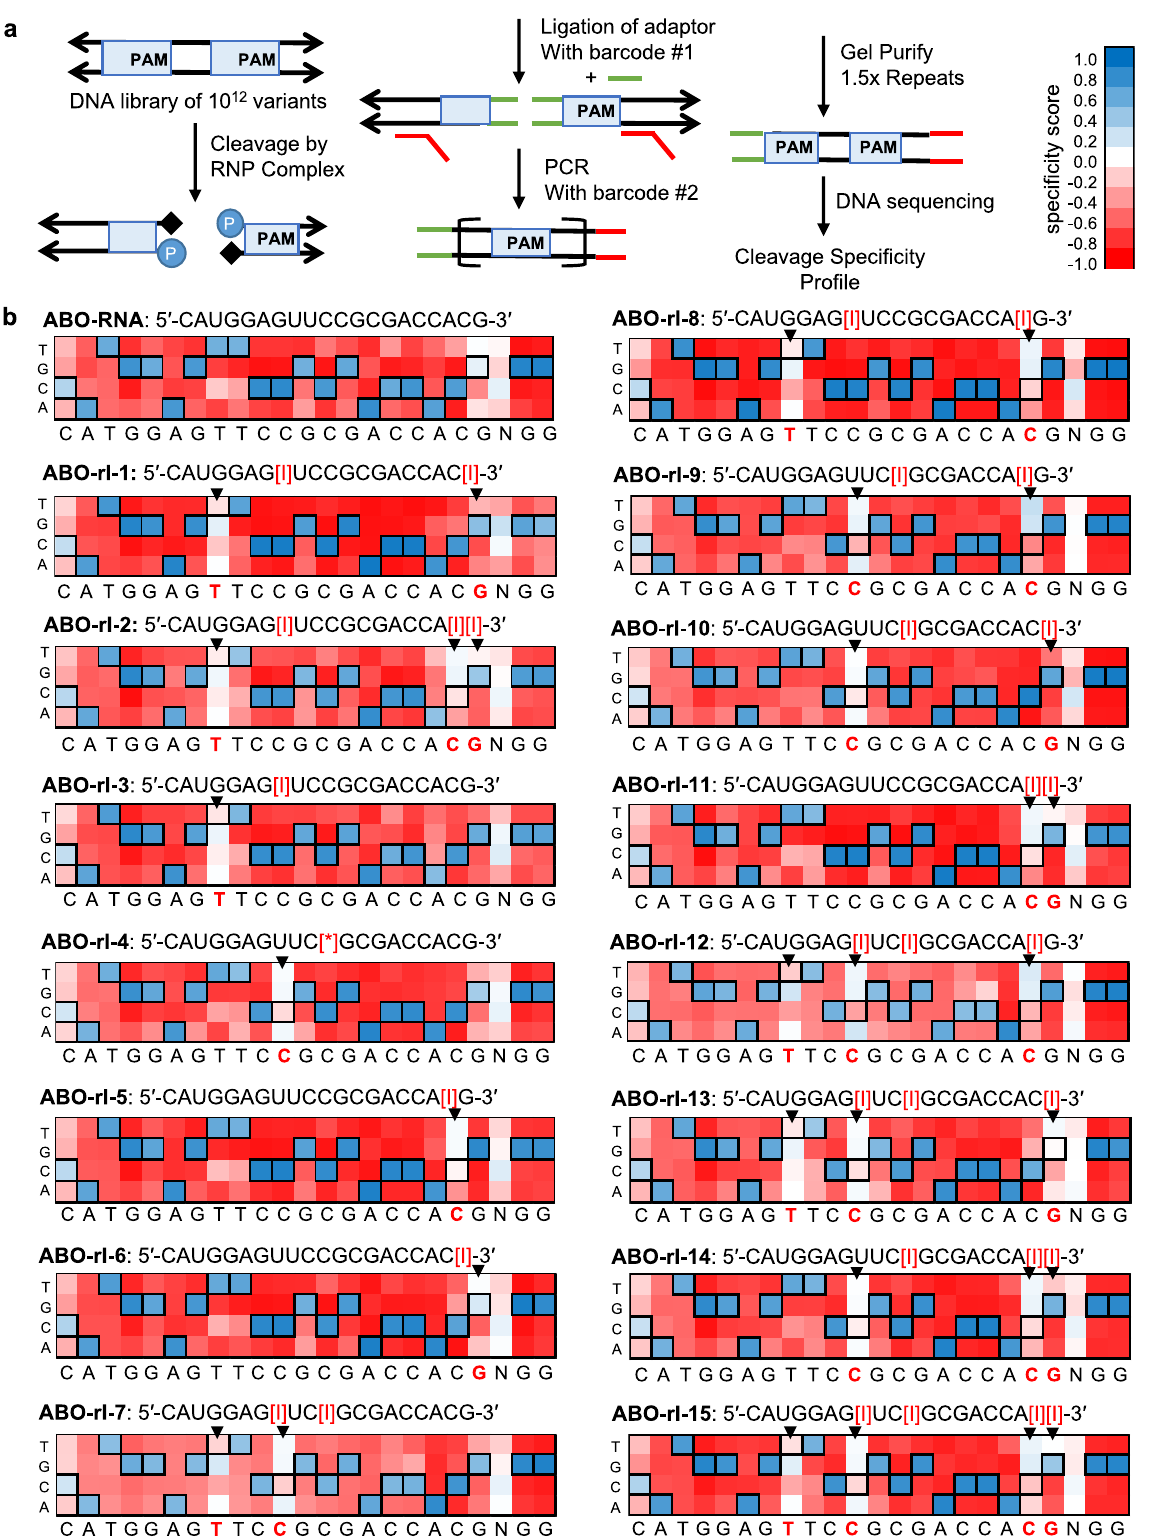
Fig. 2 Inclusion of inosine bases in crRNAs affects speci fi city mainly at the site of incorporation. a Diagram depicting the work fl ow for the high- throughput speci fi city pro fi ling assay. b Heatmaps corresponding to the speci fi city pro fi les of the indicated ribose inosine-modi fi ed crRNAs. The positions of inosine bases are indicated by black arrows. Speci fi city scores of 1.0 (dark blue) correspond to 100% enrichment for, while scores of − 1.0 (dark red) correspond to 100% enrichment against a base-pair at a speci fi c position. Black boxes denote the intended target